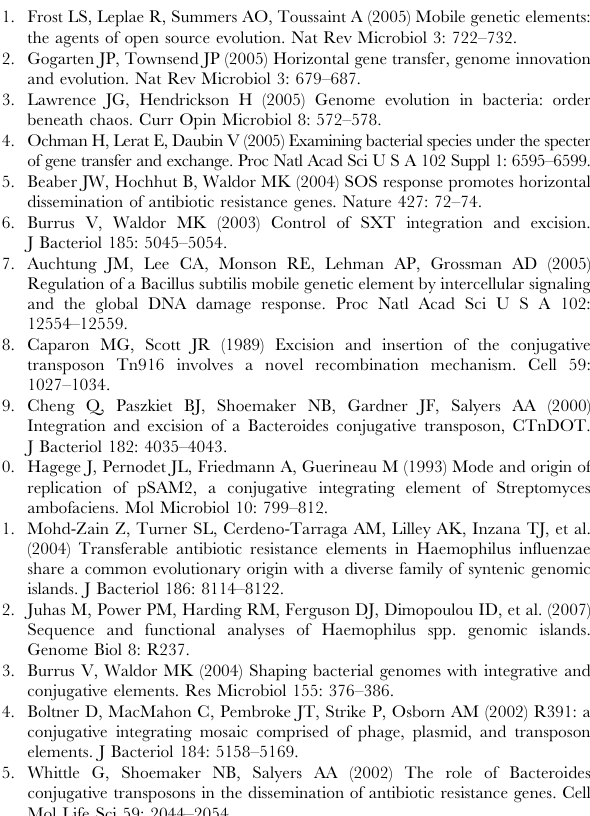
Figure S1 Variations in the conservation of individual core ICE genes. The percent identity of the nucleotide sequence of each core gene and oriT versus the corresponding sequence in SXT was calculated for all ICEs studied. The average values for each gene (as shown in the inset of Figure 5) were then used in one-way ANOVA comparisons to determine genes that exhibit significantly more or less conservation compared to other core genes. p-values of one-way ANOVA comparisons of each core ICE gene are shown. The grid represents all pair-wise comparisons, and the color indicates the level of significance as follows: red: p , .001, orange: p , .01, and yellow: p , .05. Genes that exhibited a p- value , .05 when compared with at least 50% of all other core genes are discussed in the